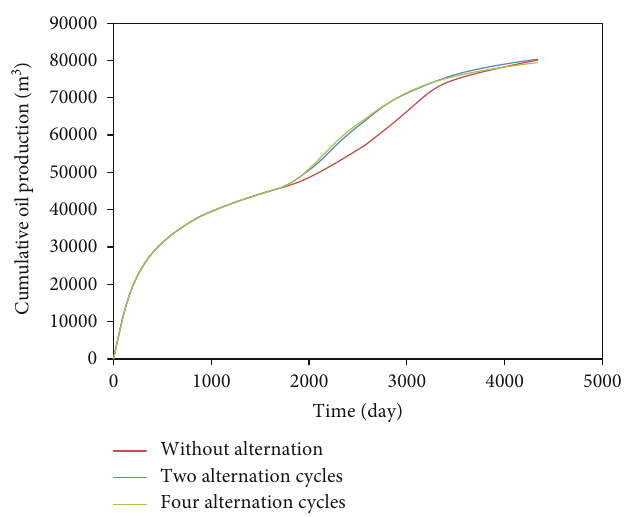
Figure 13: Cumulative oil production in di ff erent schemes.